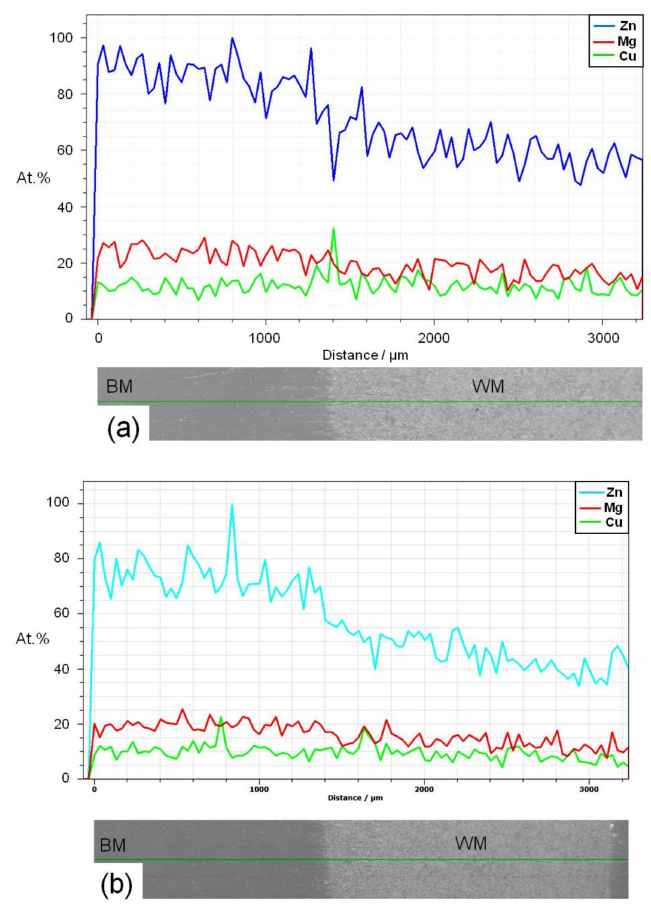
Figure 12. EDS line scan microanalysis showing the contents of Zn, Mg, and Cu elements along a 3 mm line crossing the fusion boundary of the low ( a ) and high ( b ) heat input welded joint.